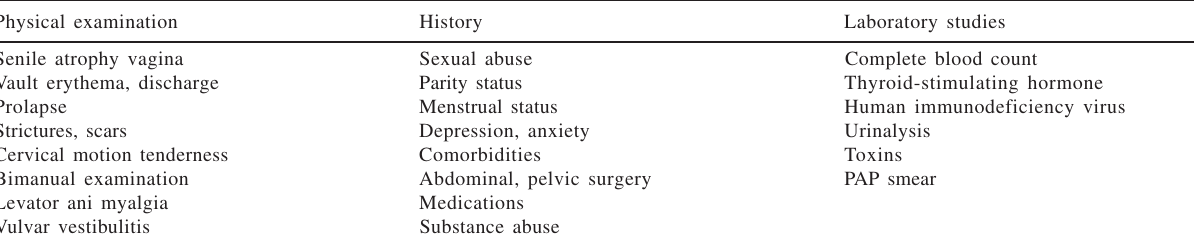
Table 1 - Evaluation of female sexual